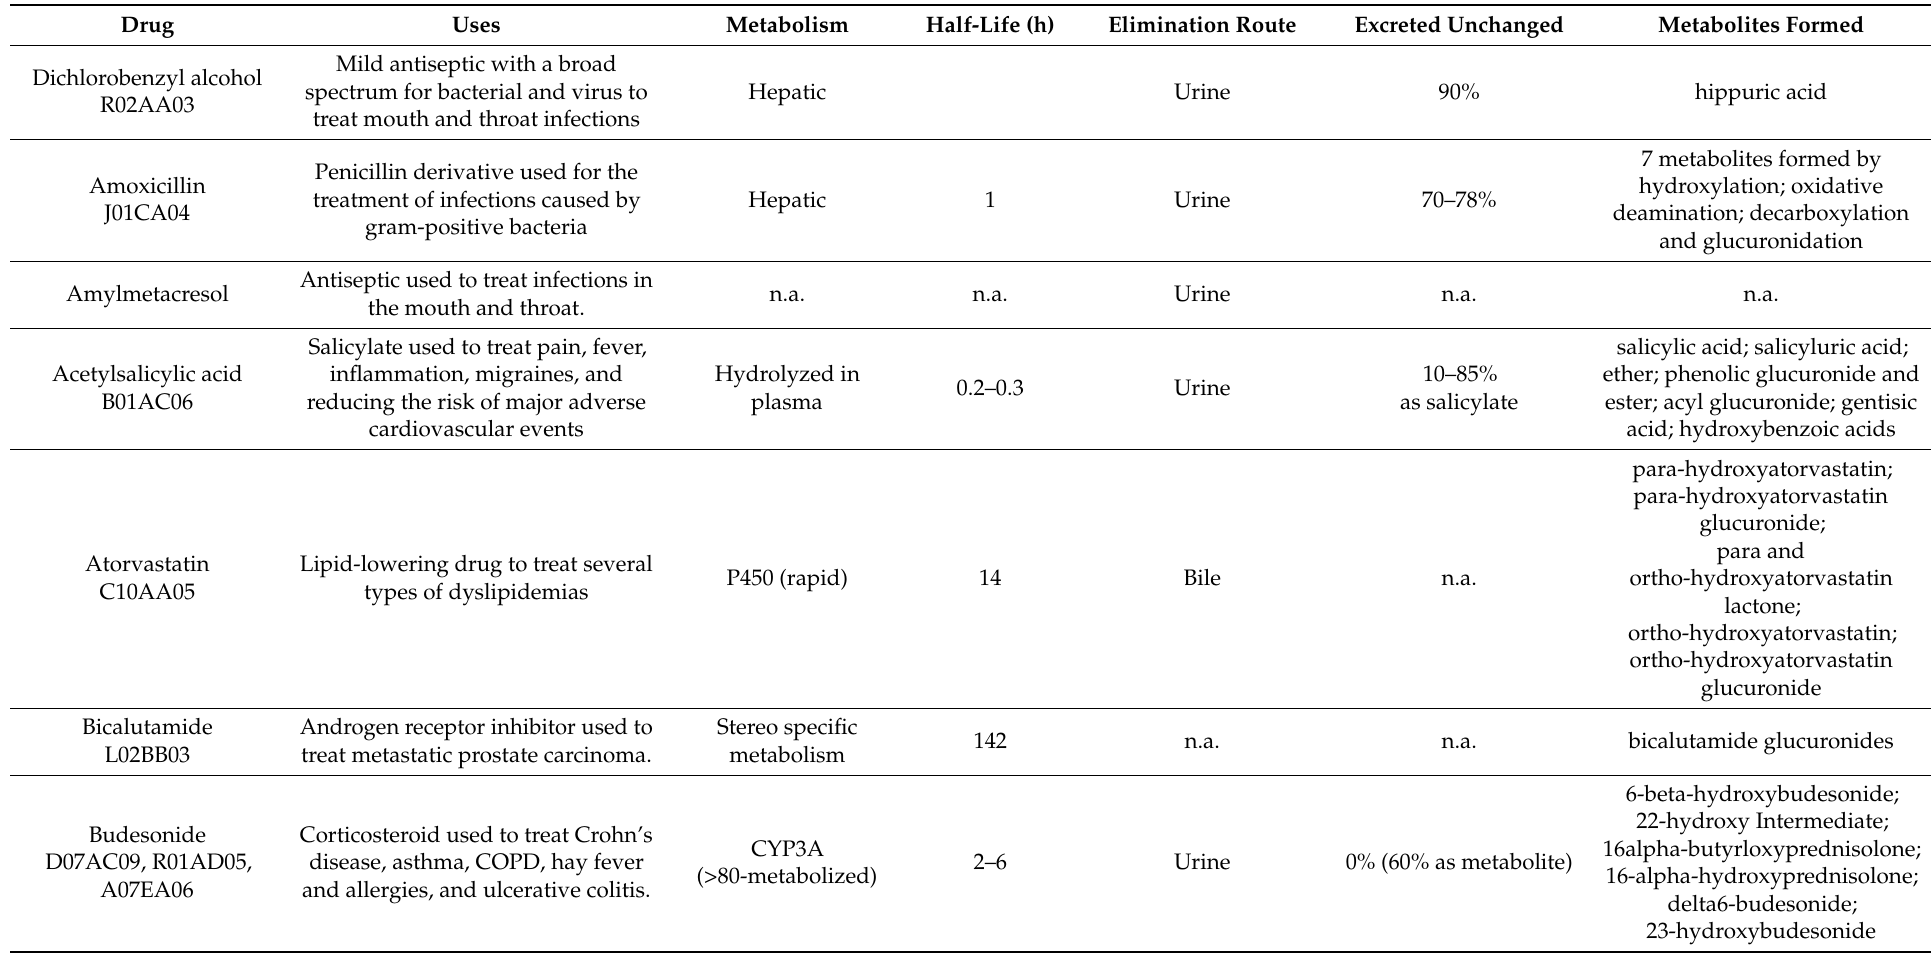
Table 2. Pharmacological properties of drugs used to determine their elimination and main metabolites excreted from each drug that can be potentially detected in water. Source: Drugbank